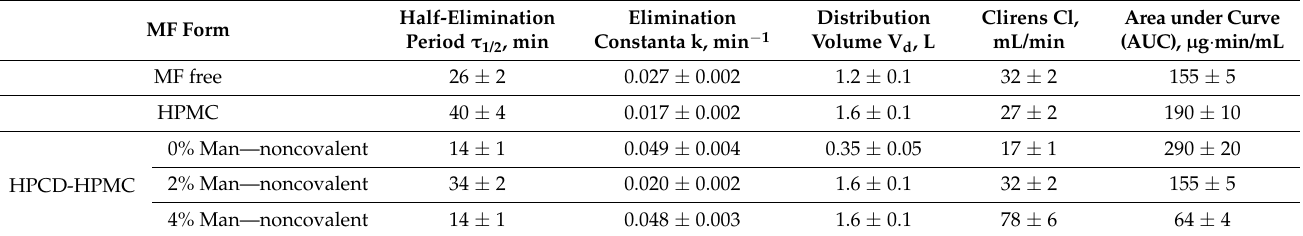
Table 3. Pharmacokinetic parameters of MF in Wistar rats. Awake animals, the study time is 48 h. Single-compartment model without